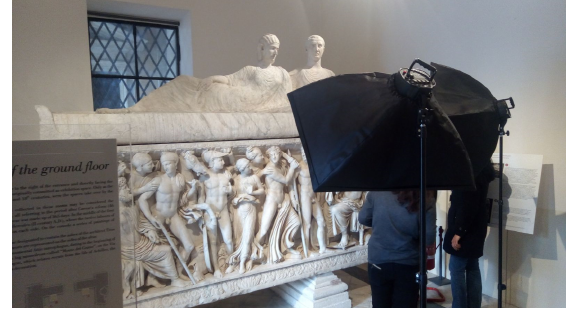
Figure 4. The use of professional illuminators was necessary when the rooms were dark or had bad illumination. In this figure is shown the preparation for the survey of the Sarcophagus of